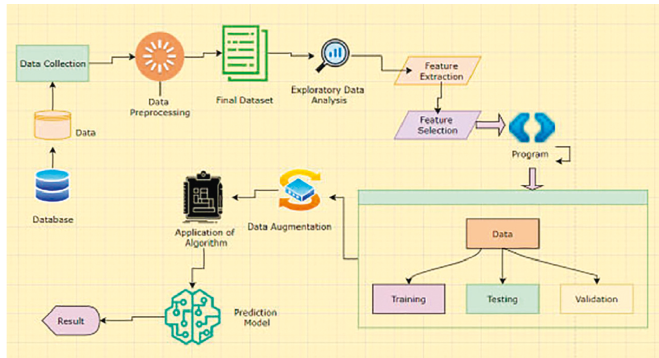
Figure 12: Architecture of proposed model.